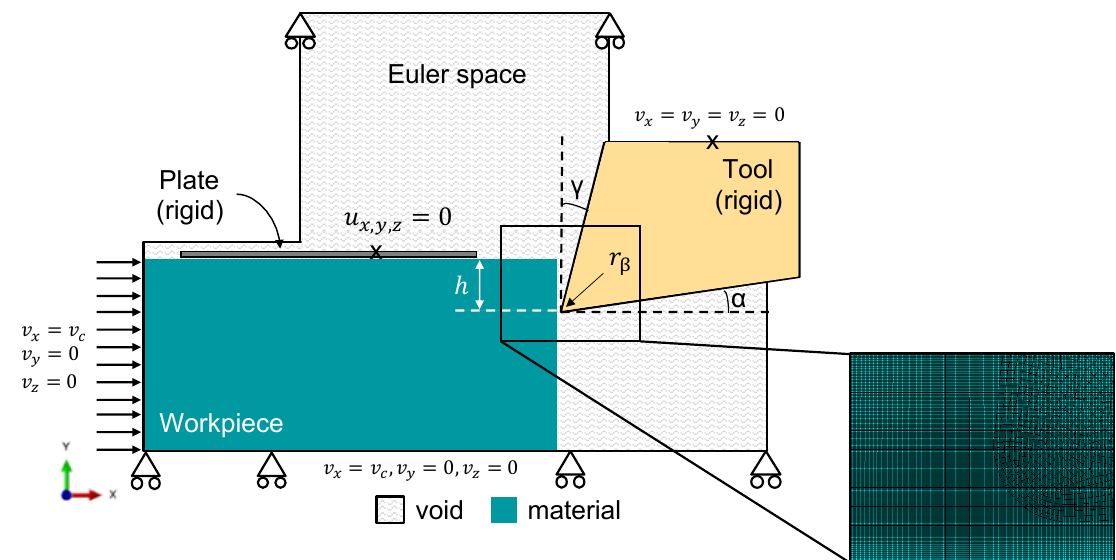
Figure 1. Orthogonal cutting model with the Coupled-Eulerian-Lagrangian method in Abaqus/Explicit. The tool and plate were meshed by utilizing the element type C3D8T , which describes an eight-node trilinear displacement and temperature element with eight Gauß points. Tool